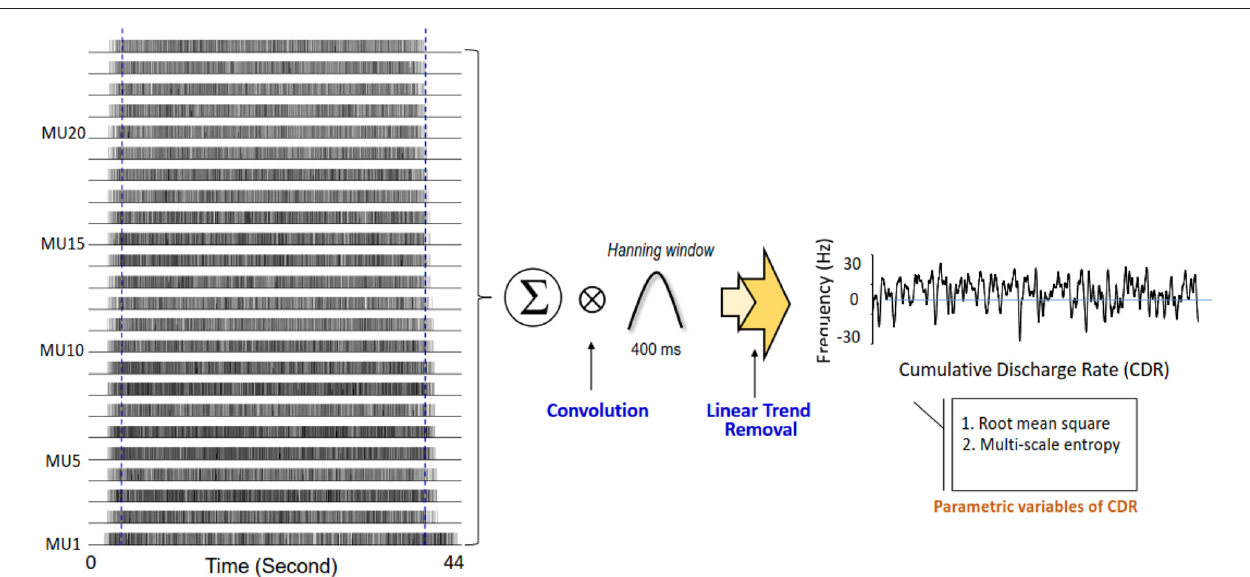
FIGURE 3 | Feature extraction of cumulative discharge rate. Cumulative discharge rate is summation of all motor unit spike trains following smoothing process and removal of linear trend. The size and complexity of cumulative discharge rate are represented with root mean square (RMS) and multi-scale entropy (MSE).